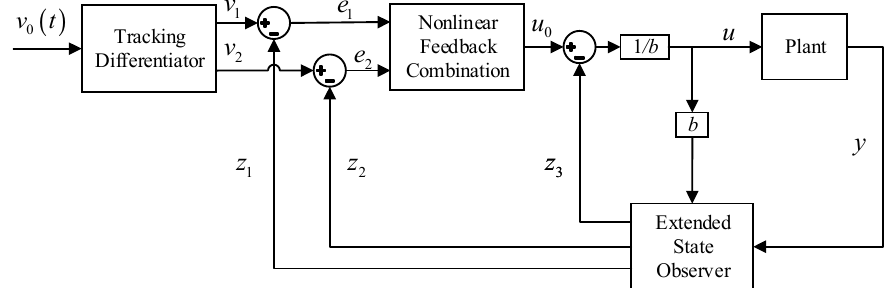
Figure 3. Control block diagram of the nonlinear ADRC.